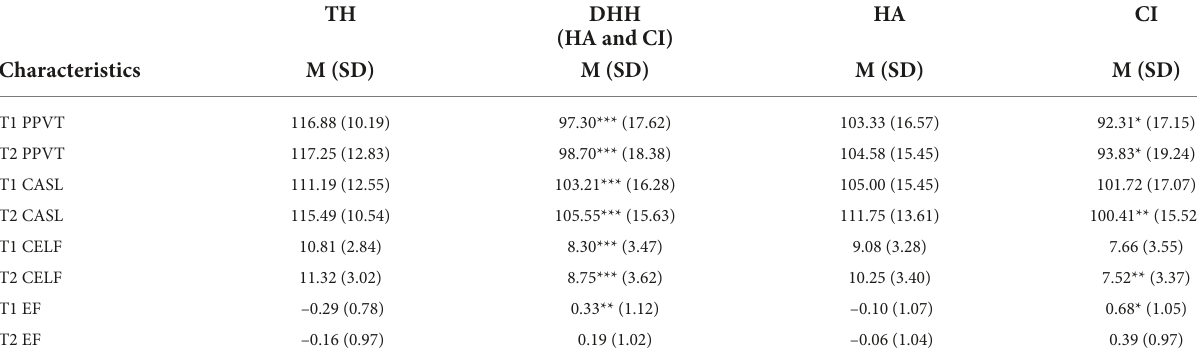
TABLE 2 T1 and T2 language and EF descriptive statistics.